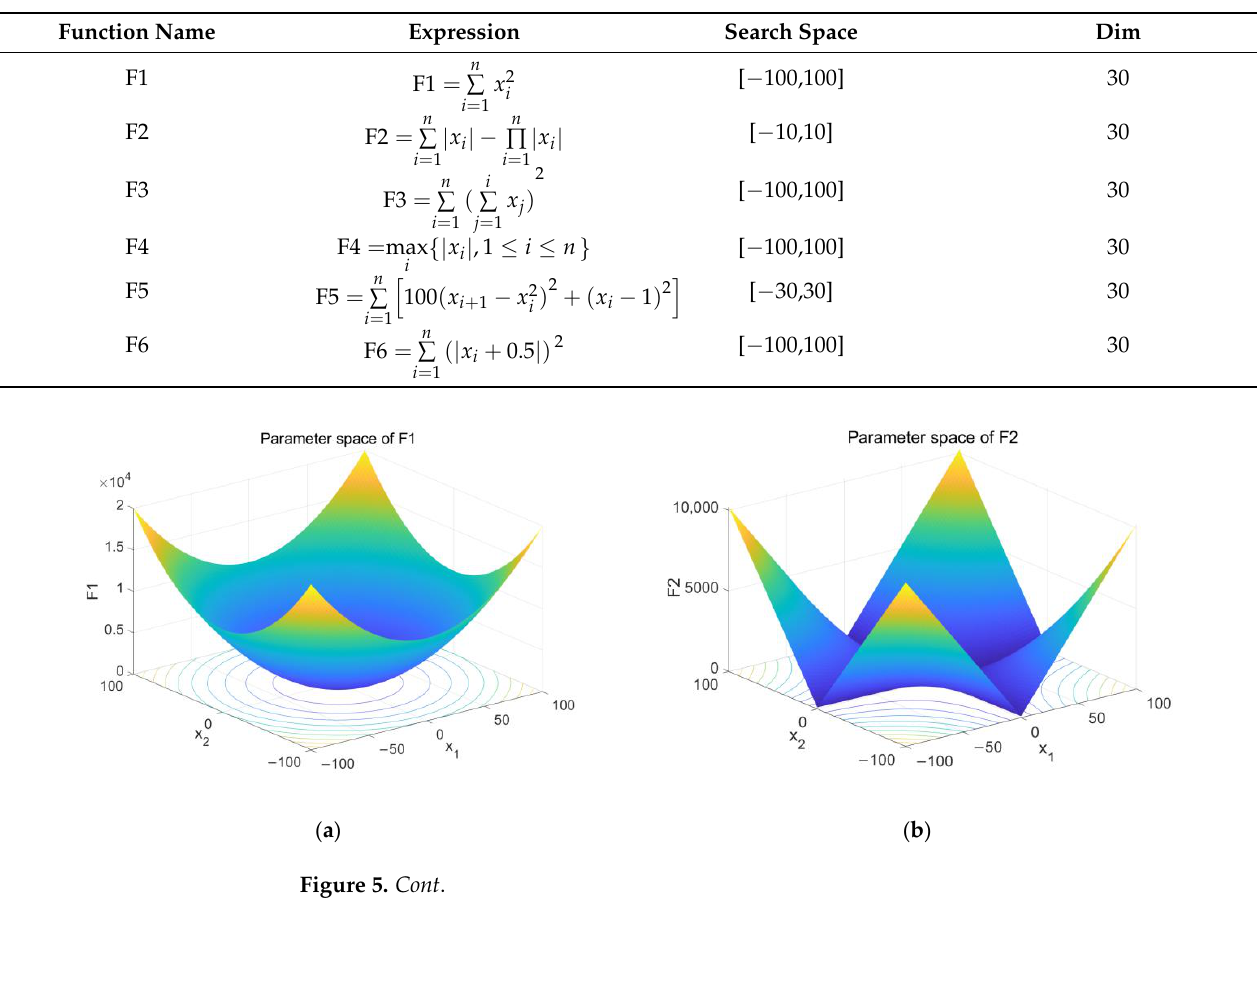
Table 2. Details of the unimodal test function.